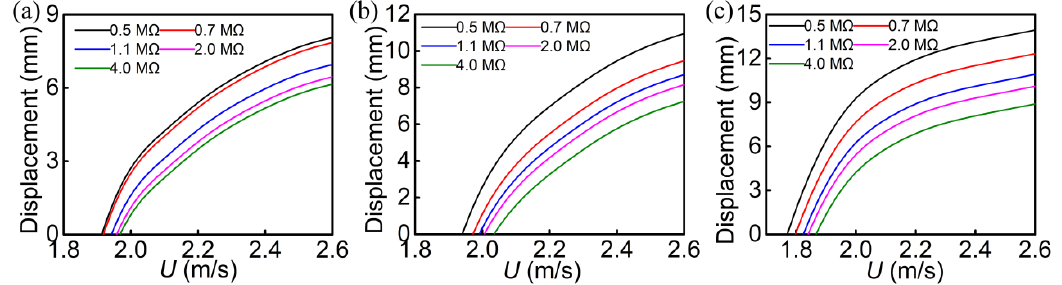
Figure 9. Numerical displacement versus wind speed: ( a ) Weak coupling k 2 /(4 ζ + 4 ζ 2 ) = 0.029; ( b ) critical coupling k 2 /(4 ζ + 4 ζ 2 ) = 1; ( c ) strong coupling k 2 /(4 ζ + 4 ζ 2 ) = 2.9.